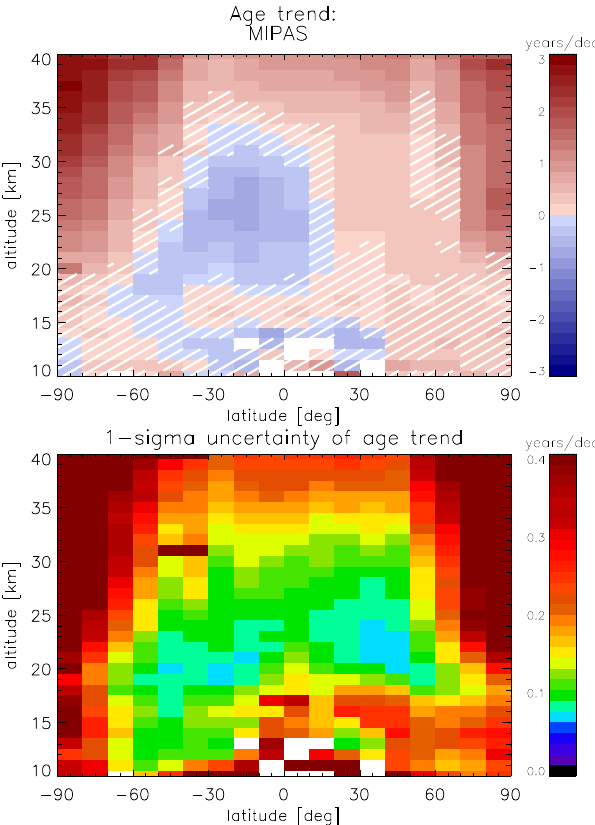
Figure 6. Top: Altitude–latitude cross-section of the model-error corrected linear increase of MIPAS AoA over the years 2002 to 2012, i.e. after including the model error and autocorrelations be- tween the data points in the fit. Hatched areas indicate where the trend is not significant, i.e. it is smaller (in absolute terms) than its 2 σ uncertainty. Bottom: 1 σ uncertainty of the trend in terms of